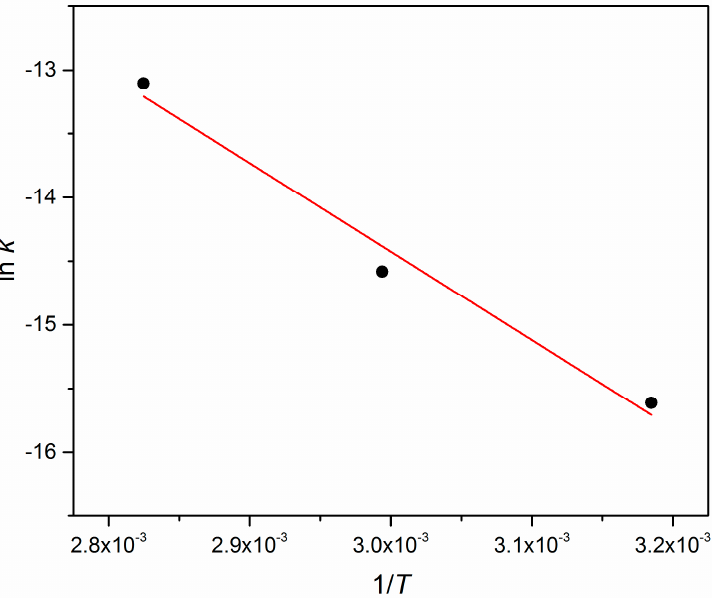
Figure A2. Arrhenius plot according to Equation (A2) of the accelerated oxidative ageing data of Canada balsam (R 2 = 0.9812). The data in Table A1 show that the 10-degree law as explained by Equation (4) is approximately fulfilled, as the rates increase by an approximate factor of 4 for every 20-degree step. Also, the Arrhenius plot displays approximately linear behaviour. The activation energy of the yellowing of Canada balsam under the influence of the atmosphere derived from the slope of the Arrhenius fit is 58 kJ/mol, i.e., below 70 kJ/mol, underlining the validity of the 10-degree law [32,33].